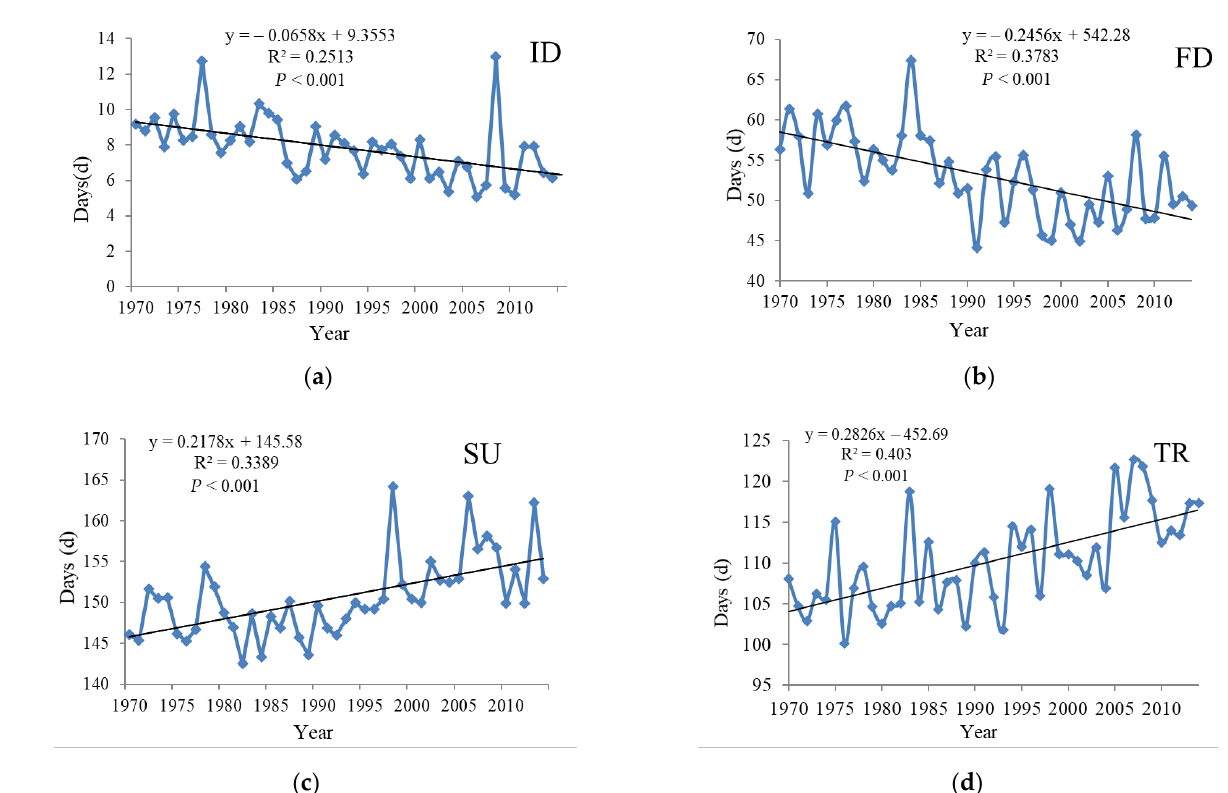
( d ) Figure 3. Spatial distribution of interannual variability of relative indices of extreme temperature in the Yangtze River Basin from 1970 to 2014. ( a ) is TX10, ( b ) is TN10, ( c ) is TX90 and ( d ) is TN90. 3.2. Temporal and Spatial Variations of Absolute Indices 3.2.1. Temporal Variation of Absolute Indices The number of ice days (ID) showed a slight decreasing trend fluctuation, and the trend was −0.66/10a ( p < 0.001). The number of frost days (FD) presented a fluctuating